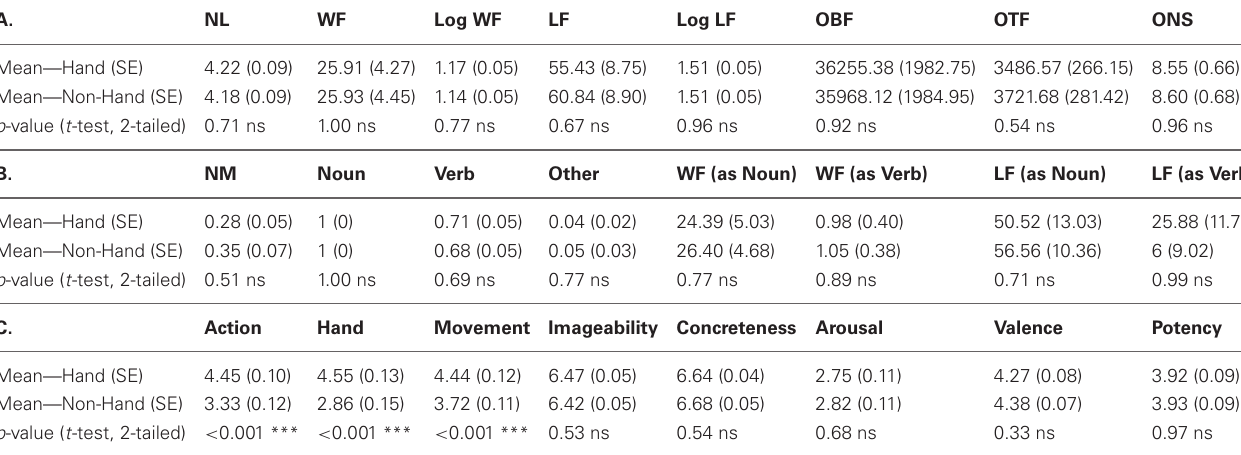
Table 1 | Psycholinguistic and semantic properties of Hand-related and Non-Hand-related word